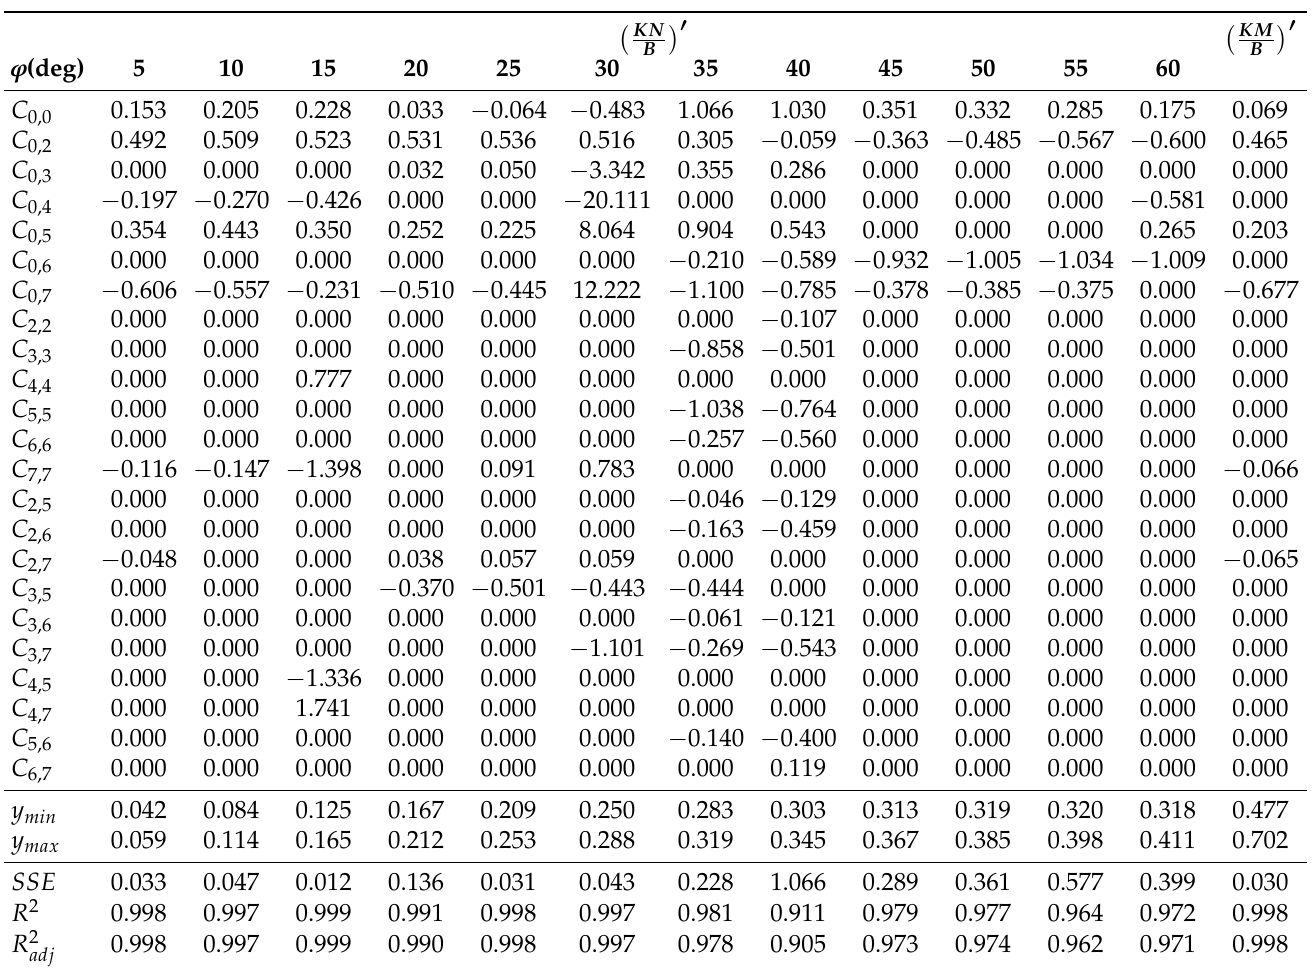
Table 6. Regression coefficients for the stability